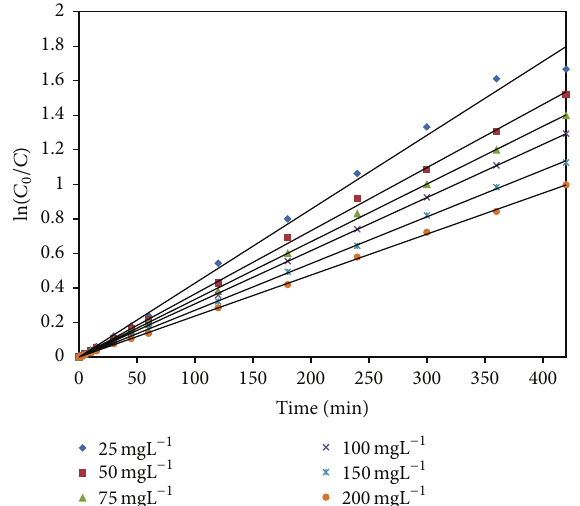
Figure 10: Langmuir Hinshelwood plot (pH: 6.8, catalyst dosage: 0.1 gL −1 , and light intensity: 500